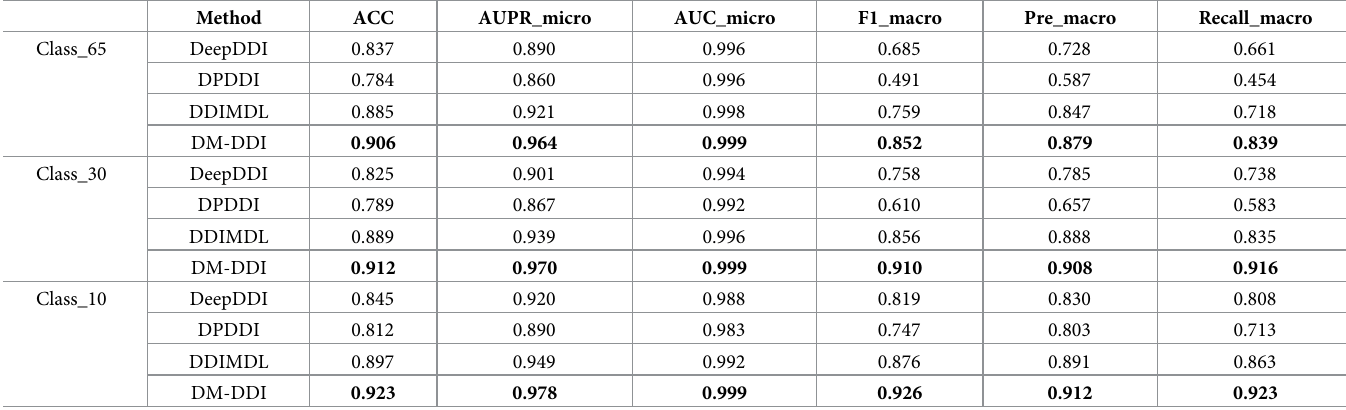
Table 5. Comparison of the link prediction results obtained over multiple classes.